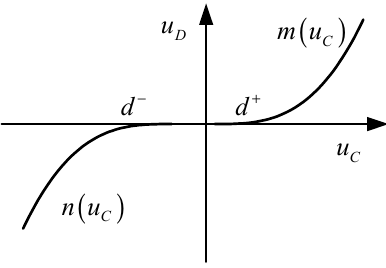
Figure 2. Non-symmetric dead zone non-linearity.